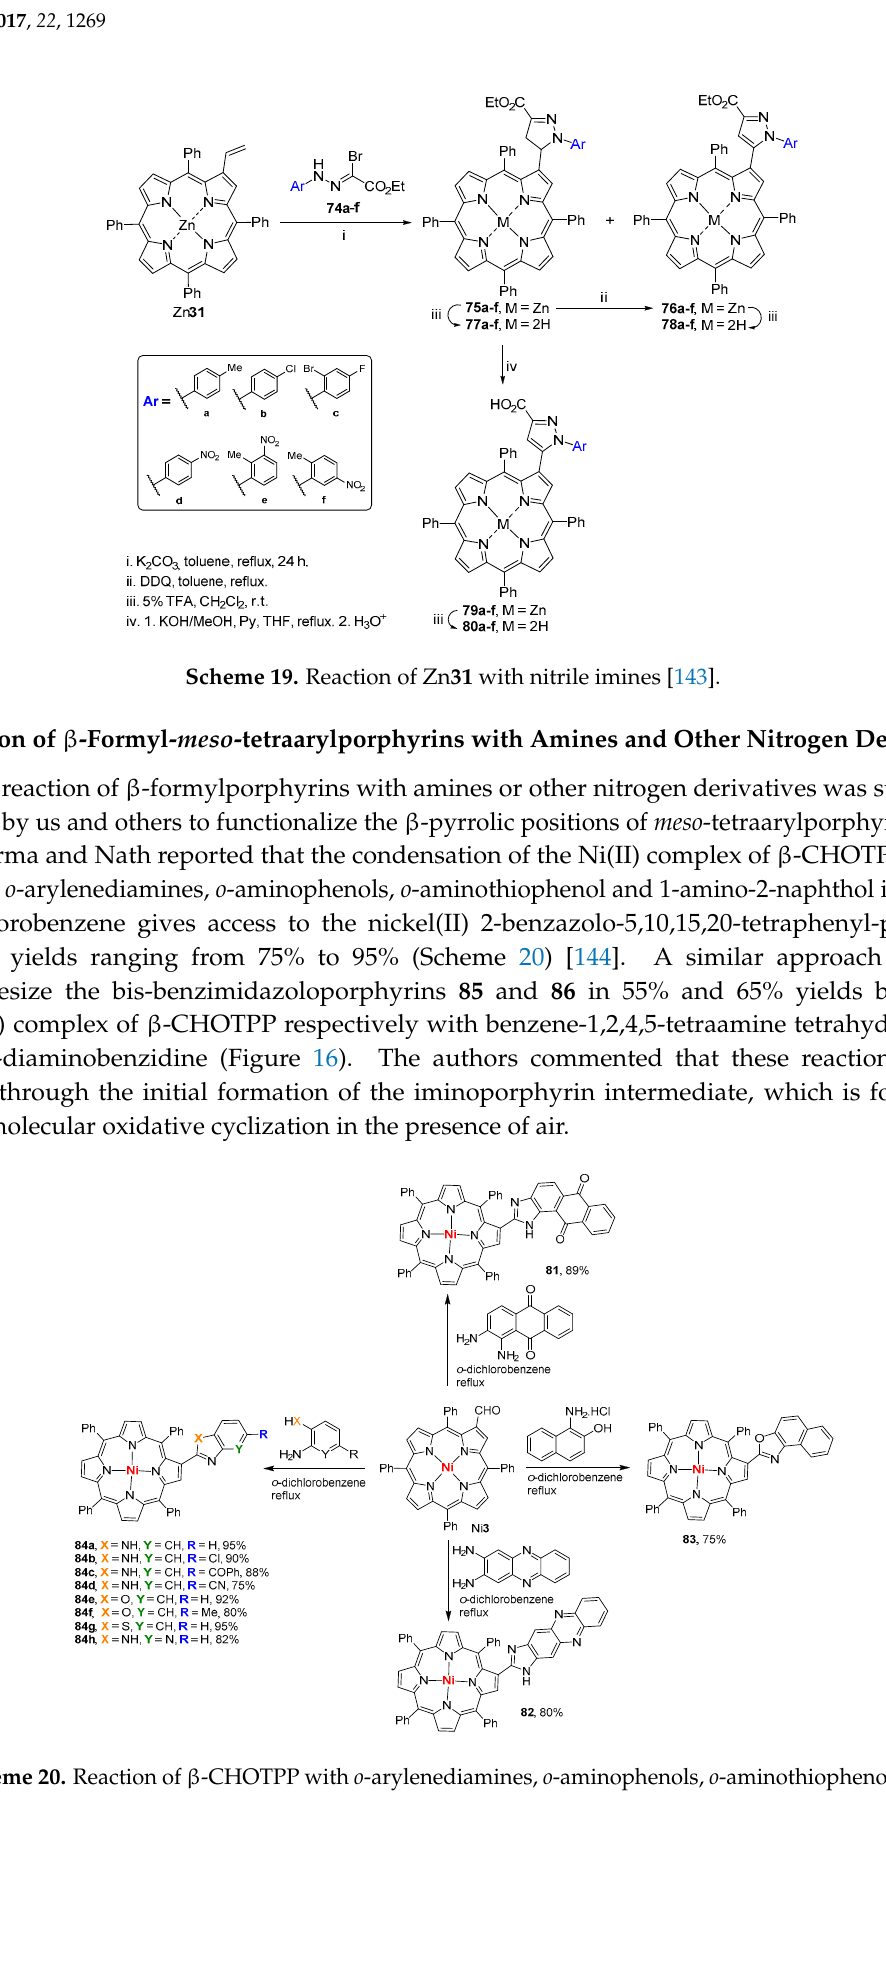
Figure 16. Dyads obtained from reaction of β -CHOTPP with benzene-1,2,4,5-tetraamine tetrahydrochloride and 3,3 ′ -diminobenzidine [144]. The same group reported recently a convenient access to the β -substituted copper(II) pyrrolo- and indolo[1,2- a ]quinoxalinoporphyrins 87 (M = Cu, 83%–89%) and 89 (M = Cu, 62%–65%) through the condensation of the adequate copper(II) β - formyl-5,10,15,20-tetraarylporphyrins with 1-(2- aminophenyl)pyrrole or 2-(3-methylindol-1-yl)phenylamine (Scheme 21) [145]. The authors found that the best conditions for these Pictet–Spengler reactions is to perform the condensations in 1,4- dioxane at temperatures between 25 to 40 °C, in the presence of p -dodecylbenzenesulfonic acid, followed by in-situ oxidation with potassium permanganate at room temperature. Using conventional protocols an efficient access to the corresponding free-bases and to the Zn(II) and Ni(II) complexes were also reported [145]. The red shift observed in the electronic absorption and in some emission spectra of the pyrrolo- and indolo[1,2- a ]quinoxalinoporphyrins in comparison to the corresponding meso -tetraphenylporphyrins were justified as being due to the extended π -conjugation. Giribabu and co-workers used the condensation between 1,2-diaminoanthraquinone and β - CHOTPP or its Zn(II) complex to prepare molecular bis(porphyrin)-anthraquinone triads having